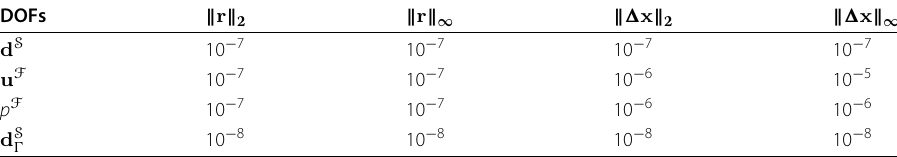
Table9 Tolerances for nonlinear convergence check for oscillating flag example